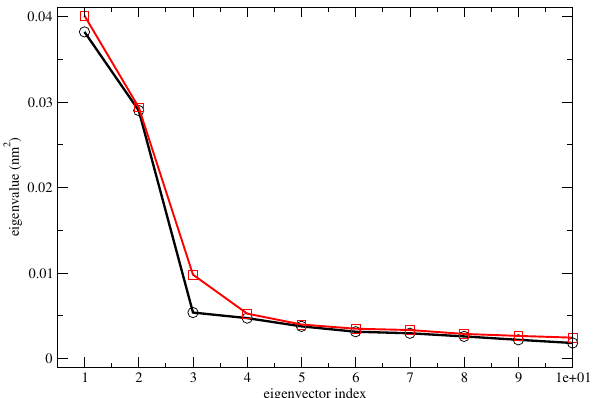
Figure 3. Spectrum of the eigenvalues of the all-atoms covariance matrix for the Alpha-Glu (black) and Beta-Glu (red).